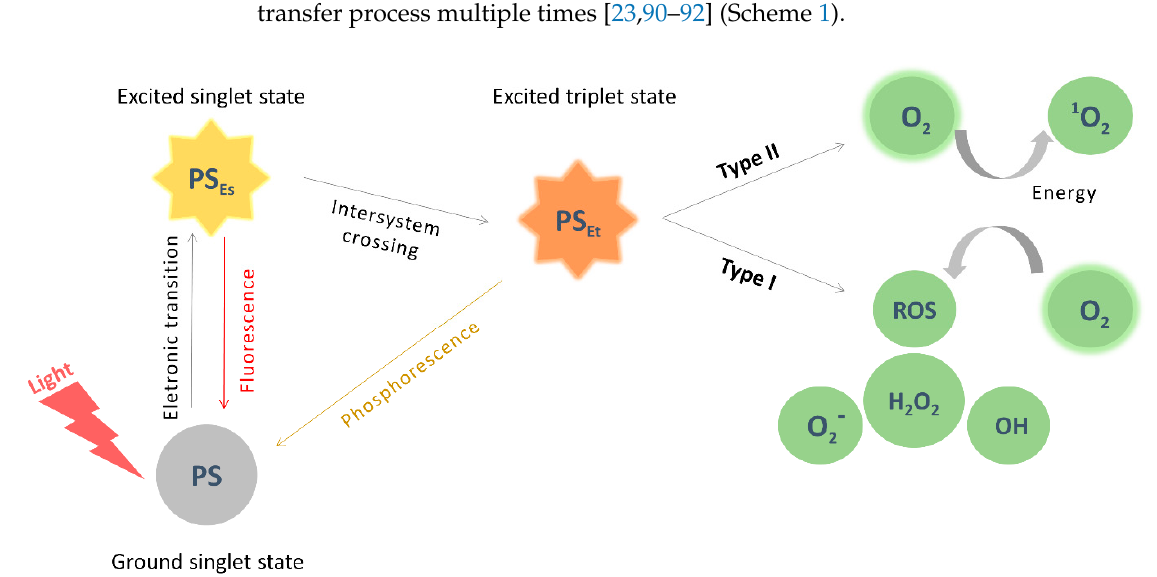
Scheme 1. Photodynamic reaction